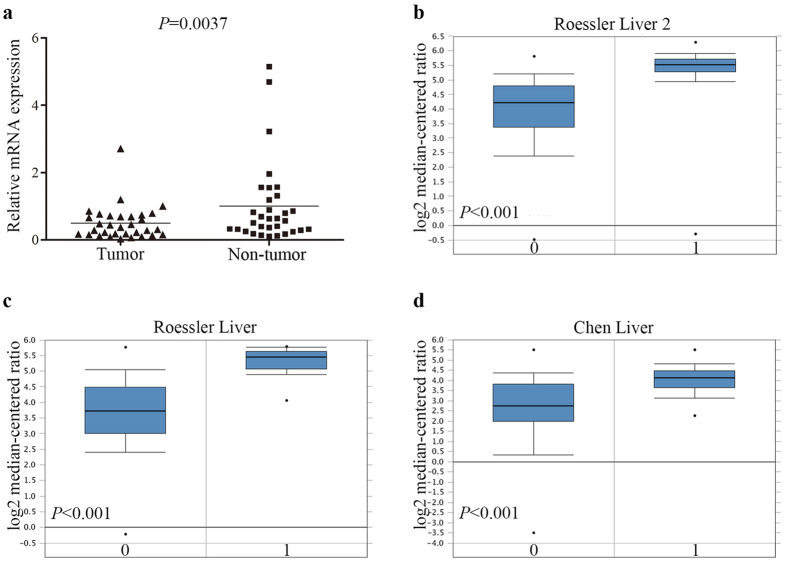
Showing expressions of SMP30 mRNA decreasing in HCC.(a) Relative mRNA expression of SMP30 in 32 paired HCC and adjacent tissues detected by qPCR. Oncomine data mining analysis of SMP30 mRNA levels in (b) Roessler Liver2, (c) Roessler Liver and (d) Chen Liver grouped by HCC (0) and normal liver (1).